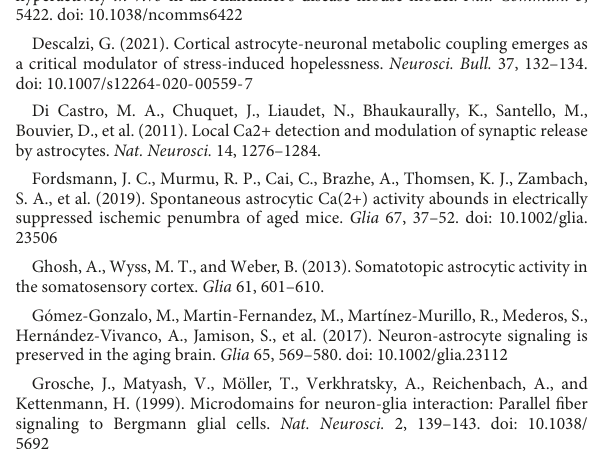
SUPPLEMENTARYFIGURE1 Specific and efficient expression of GCaMP6f in cortical astrocytes 4 weeks after AAV5-GfaABC 1 D-cytoGCaMP6f-SV40 injection. (A) Representative image showing most of the GCaMP6f (green)-labeled astrocytes were S100 β (red) positive cells. (B) High-magnification image showing immunostaining of GCaMP6f (green) and S100 β (red) as indicated by the white-dashed box in the left panel. (C) Representative image showing none of the GCaMP6f-labeled astrocytes were stained with NeuN. SUPPLEMENTARYFIGURE2 No changes to Ca 2 + transients within the somata of cortical astrocytes during brain aging. (A) The fraction of active somata within the 2–3-month-old ( n = 126 ROIs from seven mice), 7–10-month-old ( n = 126 ROIs from seven mice), and 13–16-month-old groups ( n = 116 ROIs from seven mice), all groups: χ 2 = 1.2468, P = 0.5261, χ 2 -test. (B) Bar graphs summarizing the frequencies of Ca 2 + transients within active astrocytic somata of the 2–3-month-old ( n = 48 ROIs from seven mice), 7–10-month-old ( n = 53 ROIs from seven mice), and 13–16-month-old ( n = 42 ROIs from seven mice) groups. All groups: P = 0.3233, Kruskal–Wallis test. (C) Bar graphs summarizing the amplitudes of Ca 2 + transients within astrocytic somata of the 2–3-month-old ( n = 134 Ca 2 + events from seven mice), 7–10-month-old ( n = 124 Ca 2 + events from seven mice), and 13–16-month-old ( n = 83 Ca 2 + events from seven mice) groups. All groups: P = 0.5258, Kruskal–Wallis test. (D) Bar graphs summarizing the durations of Ca 2 + transients within astrocytic somata of the 2–3-month-old ( n = 133 Ca 2 + events from seven mice), 7–10-month-old ( n = 117 Ca 2 + events from seven mice), and 13–16-month-old ( n = 80 Ca 2 + events, seven mice) groups. All groups: P = 0.0920, Kruskal–Wallis test. (E) Proportions of different peak types of Ca 2 + transients within somata of the 2–3-month-old ( n = 138 Ca 2 + events from seven mice), 7–10-month-old ( n = 128 Ca 2 + events from seven mice), and 13–16-month-old groups ( n = 87 Ca 2 + events from seven mice). All groups: P = 0.7468, Fisher’s exact test. All data are shown as the mean ± SEM. SP, singlepeaks; MP, multipeaks; PL, plateaus; S,